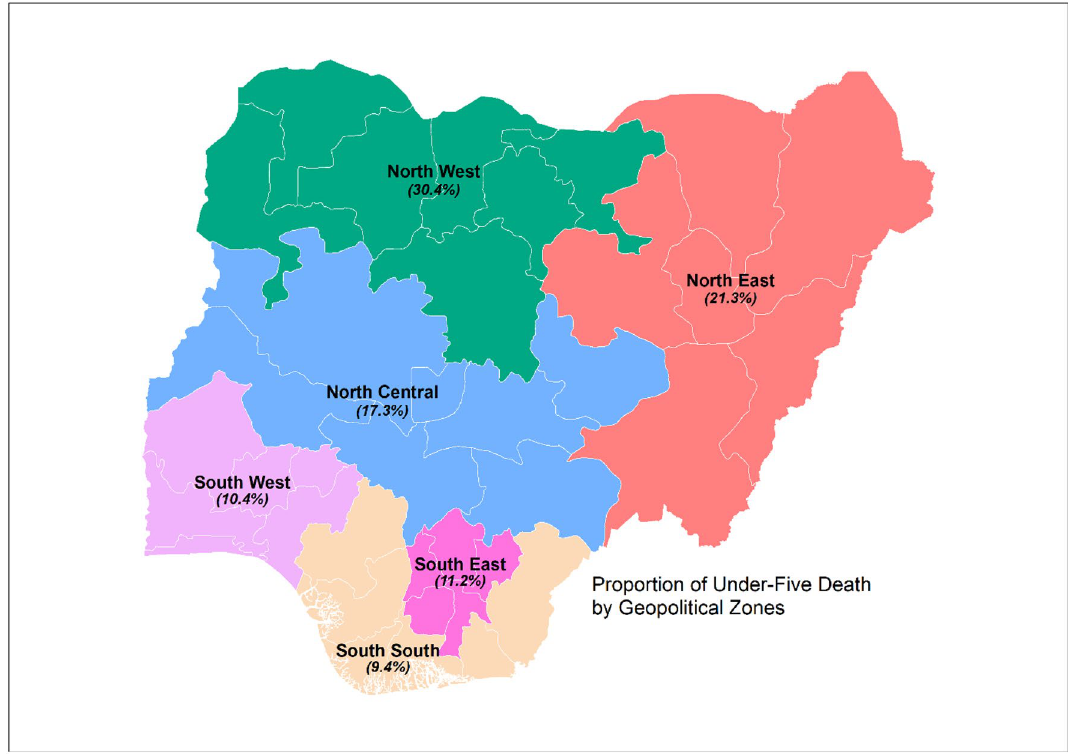
Figure 1. Proportion of under-five (U5) death by geopolitical zones of Nigeria (Source: http:// www. gadm. org (data); software: ArcMap version 10.8.1 (Esri), http:// www. esri.